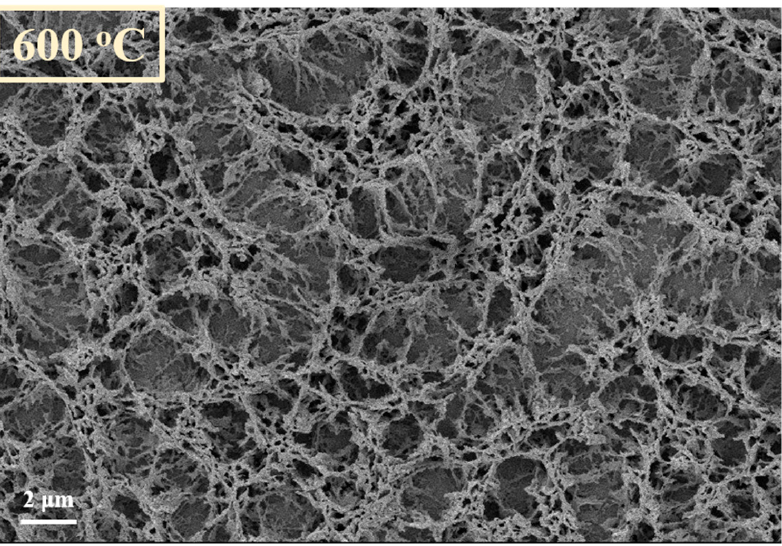
Figure 13. Image of hybrid nanostructures obtained after the decoration process, in presence of plasma, at 600 °C.